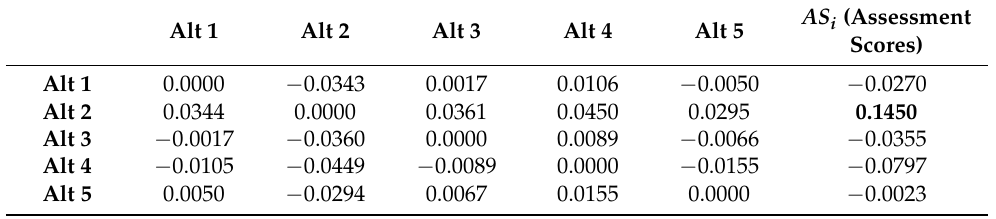
Table 18. Relative assessment matrix and assessment scores in relation to the alternatives.